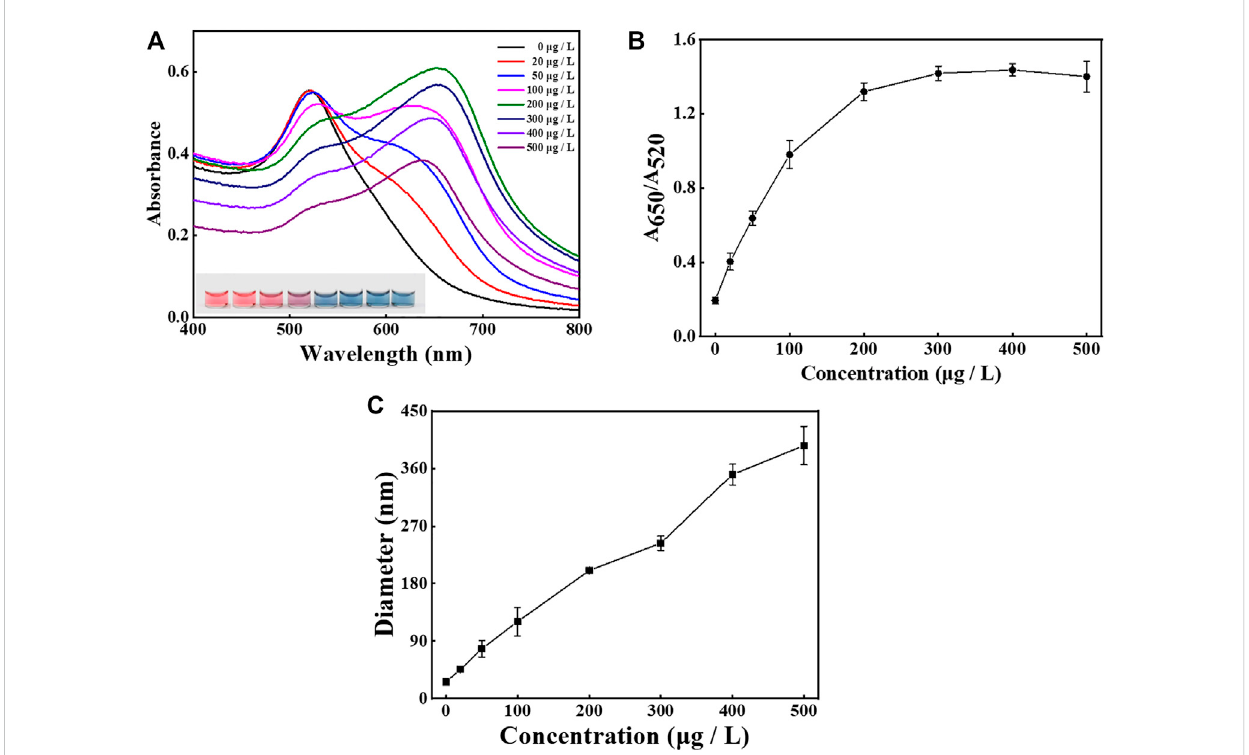
FIGURE 3 Condition investigation. The effect of protamine concentration (from 0 to 500 μ g/L) on the sensing performance. (A) The UV-Vis spectra of AuNPs and sample images after the addition of protamine with varying concentrations. (B) The values of A 650 /A 520 after the addition of protamine with varying concentrations. (C) TheDLSsizesofAuNPsaftertheadditionofprotaminewithvaryingconcentrations.Theerrorbarsrepresentthestandarddeviationof three independent